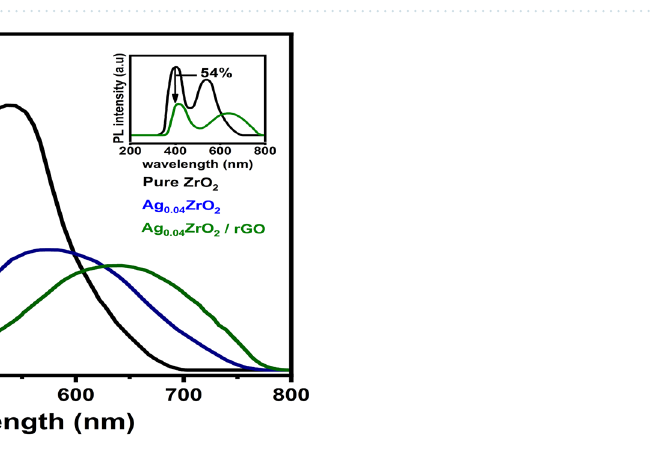
Figure 4. Photoluminescence (PL) spectra of ZrO 2 , Ag 0.04 ZrO 2 , and Ag 0.04 ZrO 2